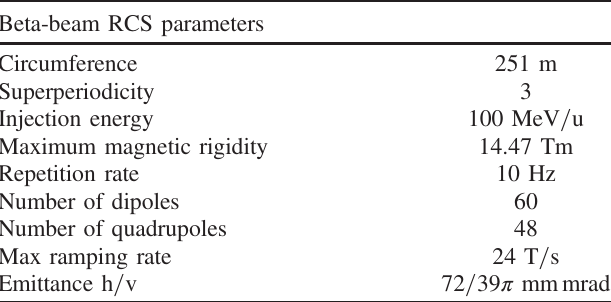
TABLE V. Beta-beam requirements for the RCS. Beta-beam RCS